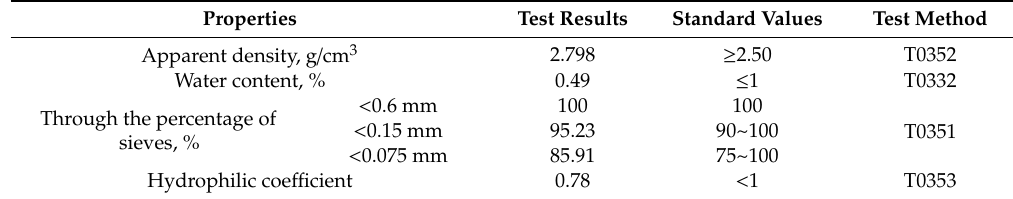
Table 2. Properties of mineral